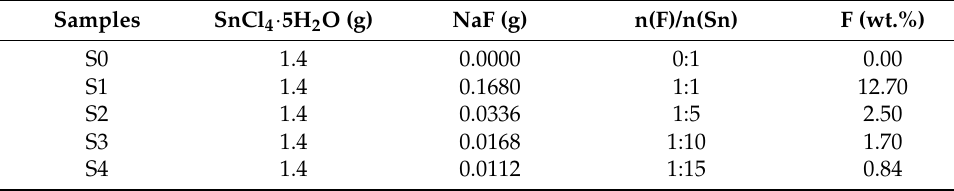
Table 2. Preparation of SnO 2 powders with different F doping